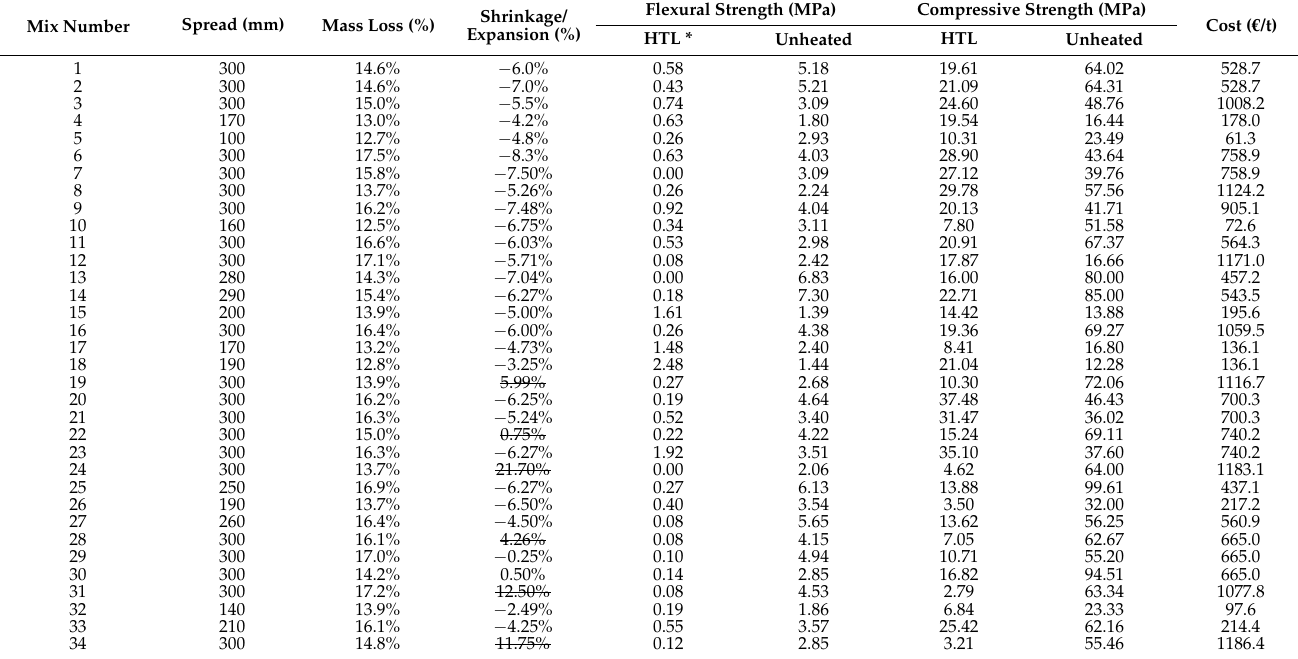
Table 4. Experimentally evaluated responses of ferronickel slag-based alkali-activated